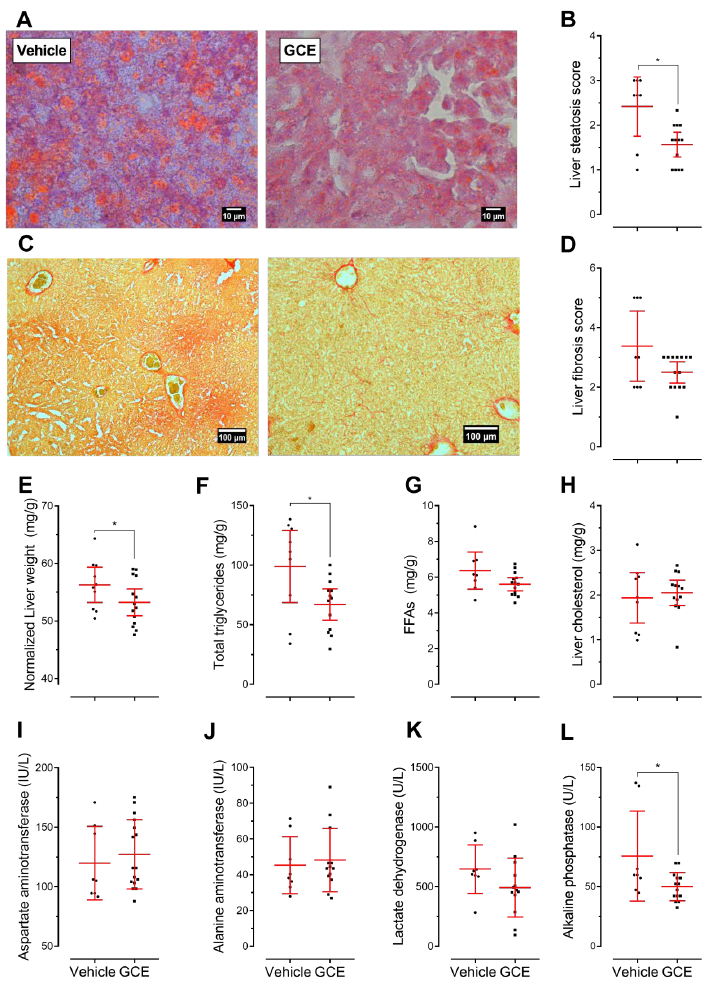
Figure 4. Green coffee extract (GCE) treatment ameliorated lipid accumulation and fibrosis in the livers of ApoE -/- high-fat diet-fed mice. ( A , C ) Representative microphotographs from liver sections stained with Oil Red O/hematoxylin and the steatosis assessment of these sections. ( B , D ) Picrosirius red stained sections and liver fibrosis assessed as collagen deposition. Liver steatosis and fibrosis were scored according to the criteria described in supplementary Table S2. ( E ) Liver weight normalized to total body weight. ( F – H ) Total liver triglycerides, free fatty acids, and cholesterol contents, respectively. Markers of liver function: ( I ) aspartate aminotransferase, ( J ) alanine aminotransferase, ( K ) lactate dehydrogenase, and ( L ) alkaline phosphatase. The results are presented as the mean ± 95% confidence intervals, and p -values from unpaired two-tailed t -tests are expressed as follows: * p <